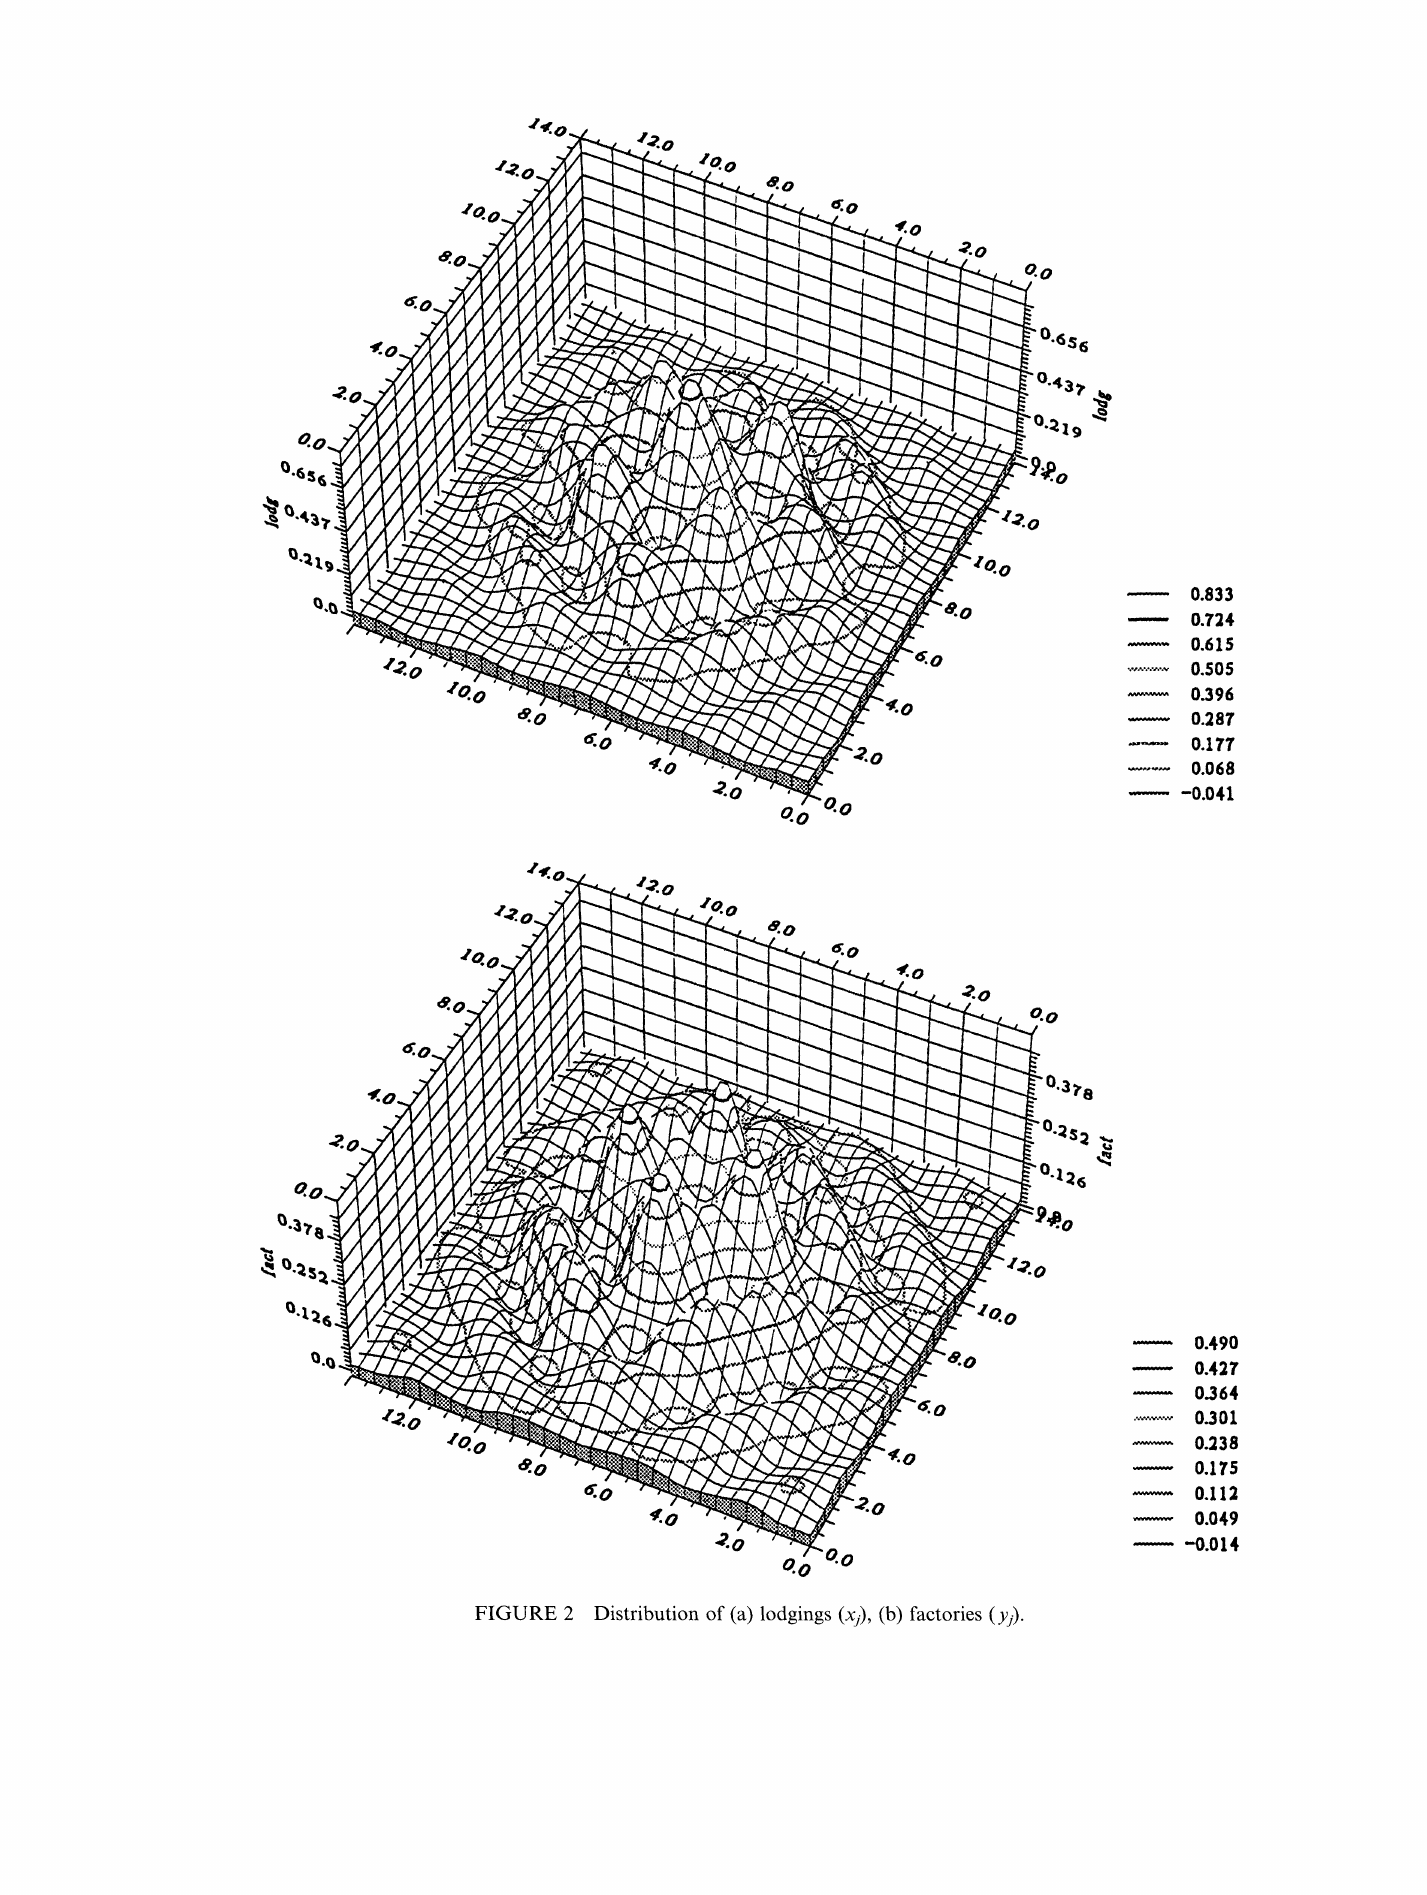
FIGURE 2 Distribution of (a) lodgings (x/), (b) factories